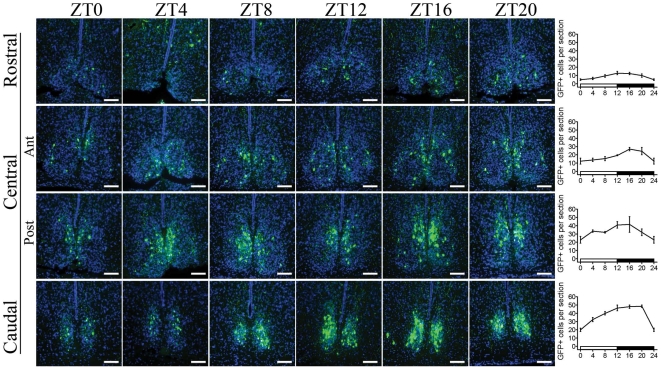
Circadian oscillation of the number of EGFP-positive neurons in the SCN.Comparisons of consecutive coronal sections through the rostral to caudal extent of the SCN at different zeitgeber time (ZT) points showed that more EGFP-positive cells located in the caudal half of the SCN than the rostral part. In both rostral and caudal parts of the SCN, the EGFP signals peaked around ZT12. Scale bar  =  50 µm. Cell nuclei were counter stained in blue.